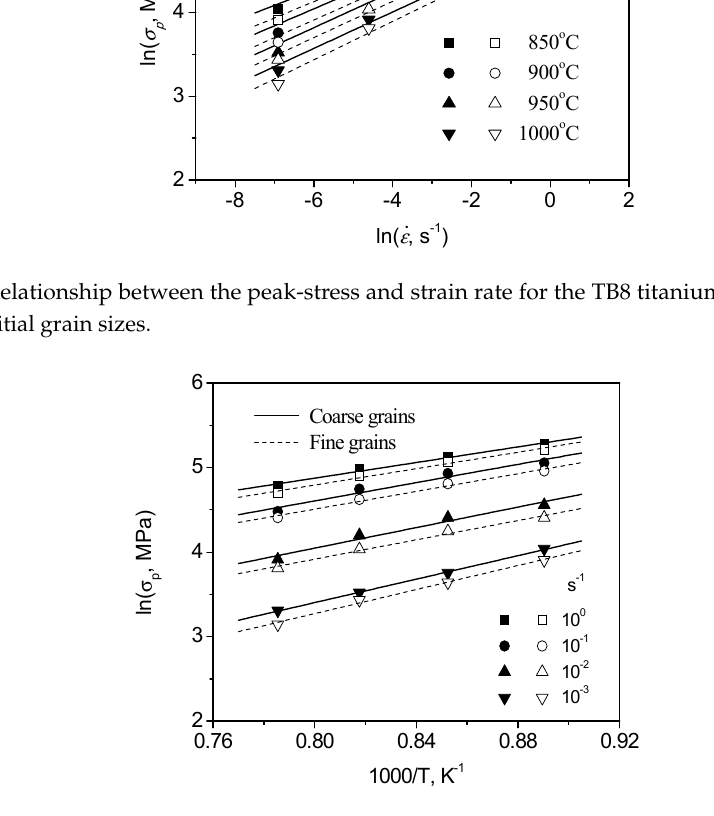
Figure 5. Relationship between the peak-stress and deformation temperature for the TB8 titanium alloys with two different initial grain sizes.